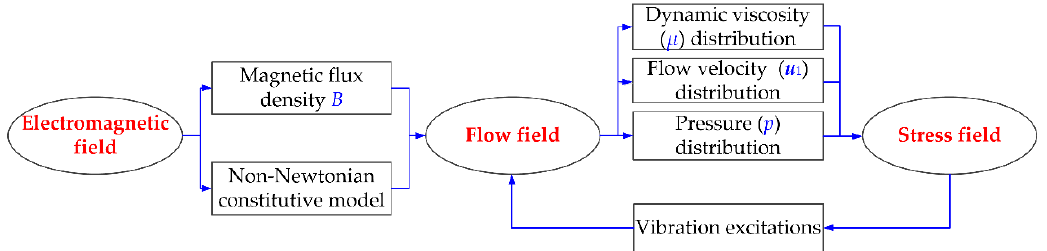
Figure 3. The coupling relationship of the physical fields of the MR damper.